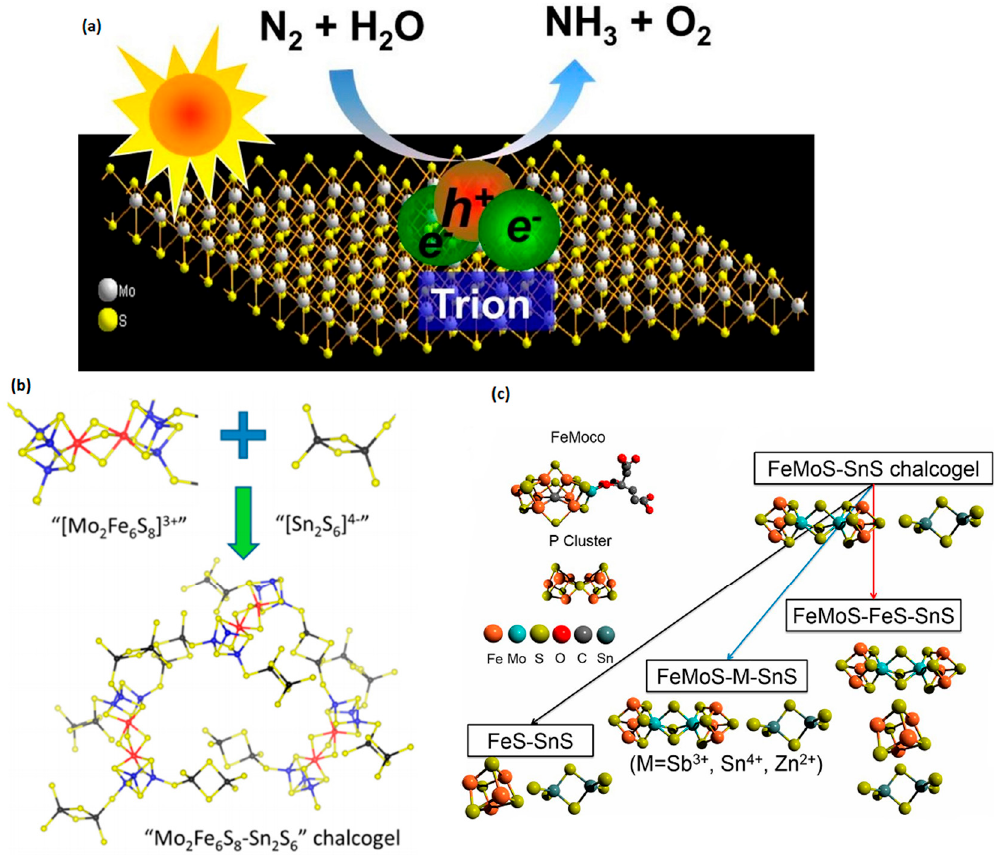
Figure 7. ( a ) Schematic illustration of the trion induced multi-electron N 2 reduction process [50]; ( b ) Schematic representation of Mo 2 Fe 6 S 8 —Sn 2 S 6 biomimetic chalcogel (FeMoS chalcogel), building block scheme (Mo, blue; Fe, red; S, yellow; Sn, black), and a complete chalcogel shown at right [51]; and ( c ) Nitrogenase-inspired biomimetic chalcogels [52]. (All the figures are reproduced with permission from the respective publishers).